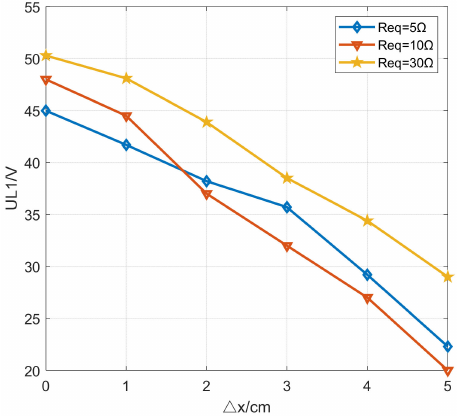
Figure 23. Output voltage when the receiving coil of load #1 is